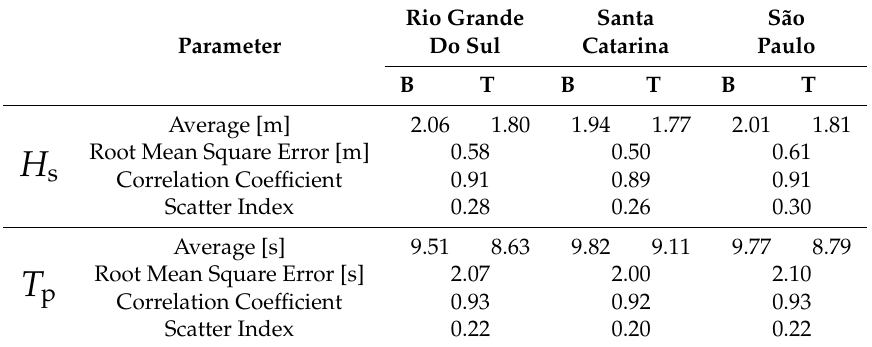
Table 2. Statistical parameters calculated using the measured buoy data (B) and the T OMAWAC output (T). Rio Grande Parameter